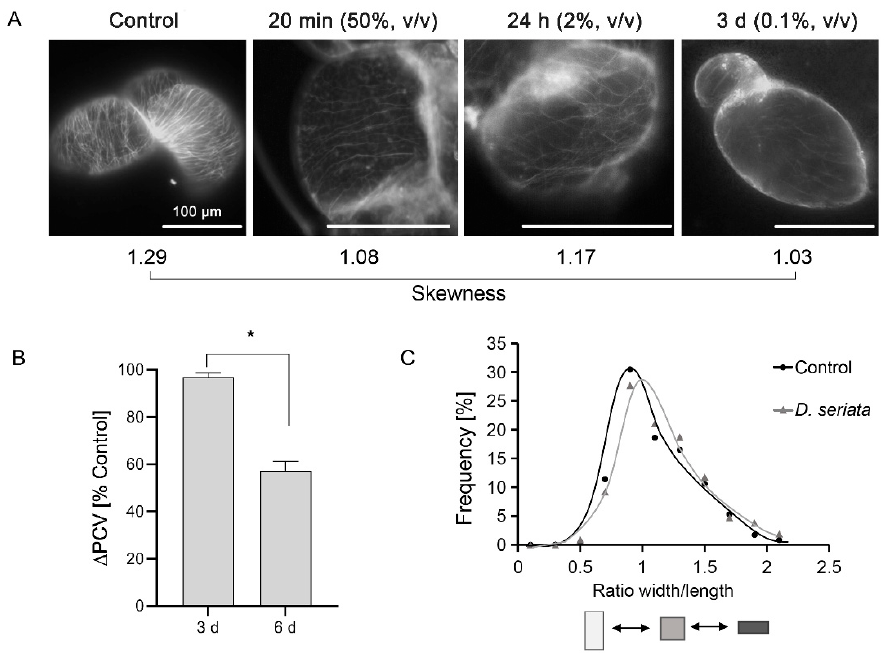
Figure 4. Phenotyping of cellular responses to D. seriata 98.1. ( A ) The response of the microtubules (MTs) to 50% ( v / v ), 2% ( v / v ), 0.1% ( v / v ) culture filtrates of D. seriata 98.1 was observed in V. rupestris